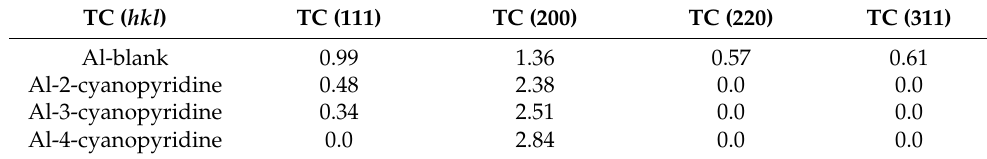
Figure 7. XRD patterns of Al coatings electrodeposited from AlCl 3 -EMIC ionic liquids with ( a ) no and 6 mM of ( b ) 2-cyanopyridine, ( c ) 3-cyanopyridine, and ( d ) 4-cyanopyridine. Table 1. Texture coefficients of the Al deposits obtained from the XRD patterns in Figure 7.